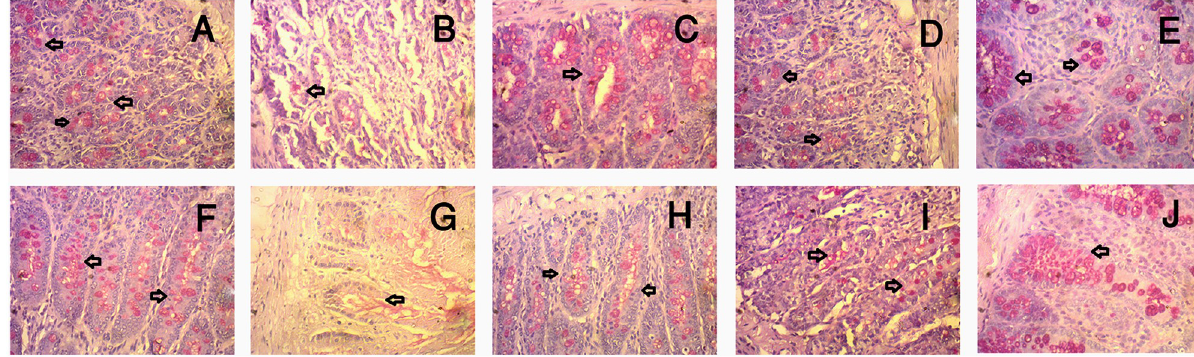
Fig 12. Effect of Senna alexandrina leaves powder supplementation on goblet cells population in crypt (upper panel) and villi (lower panel) region of intestine in high-fat diet-fed rats. A and F for control; B and G for HF; C and H for Control+SA; D and I for HF+SA and E and J for HF +ATO group. Magnifications